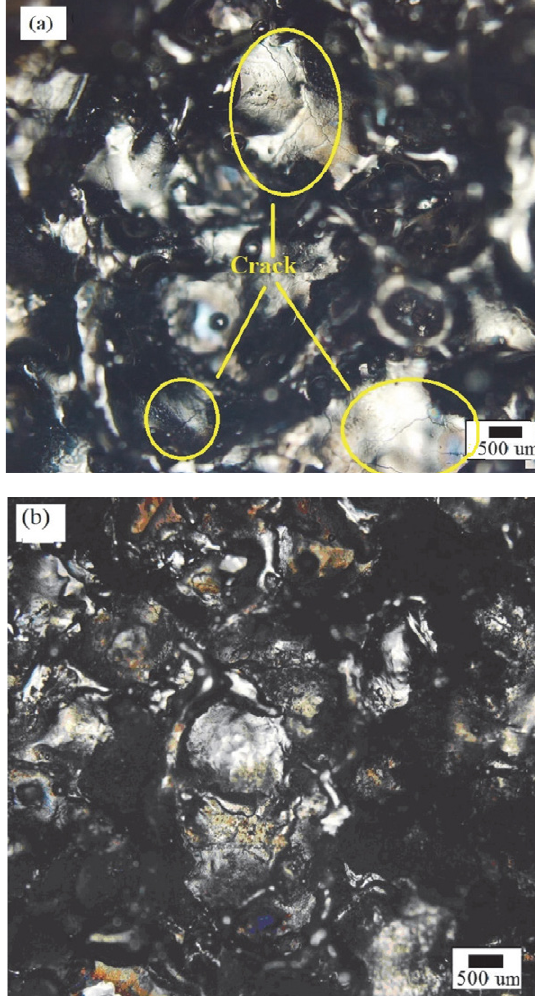
Figure 8. Optical micrograph of stainless steel EDMed through copper electrode at high discharge current and (a) high t on , (b) low t on by magnification of